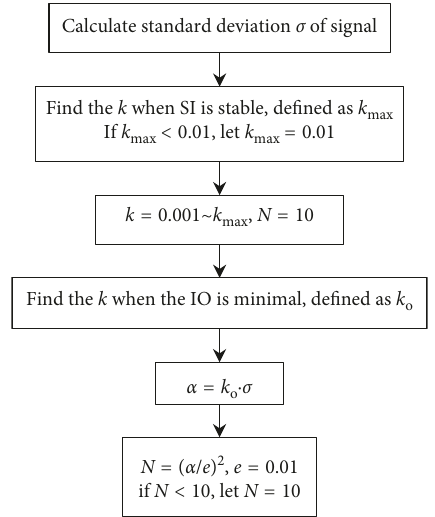
Figure 8: Selection algorithm of EEMD